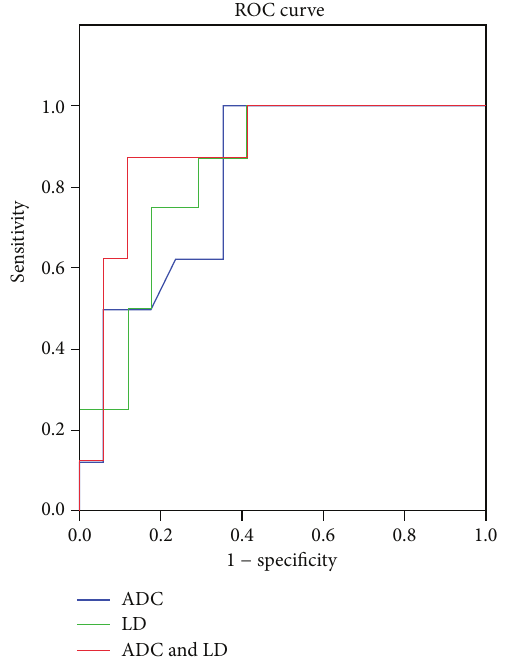
Figure 4: Compared with the change of apparent diffusion coeffi- cient (ADC) value or tumor diameters alone, the combination of the change of ADC value and longest diameter (ADC & LD) had a higher area under the curve than any other alone for evaluating lung cancer treatment response (0.890, 0.827, and 0.838 for the combination, the change of ADC value, and longest diameter (LD),